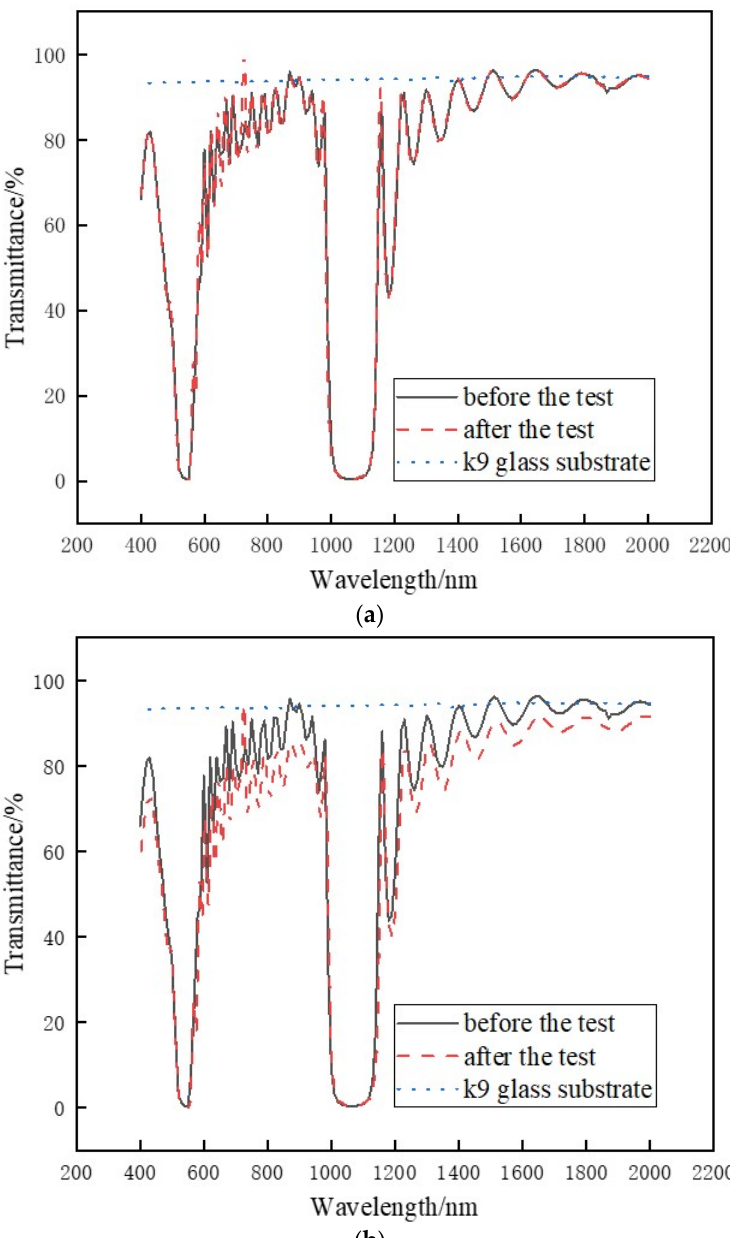
Figure 3. Transmission spectra of the non-regularized highly reflective HfO 2 /SiO 2 film before and after testing at ( a ) 1064 nm and ( b ) 532 nm.